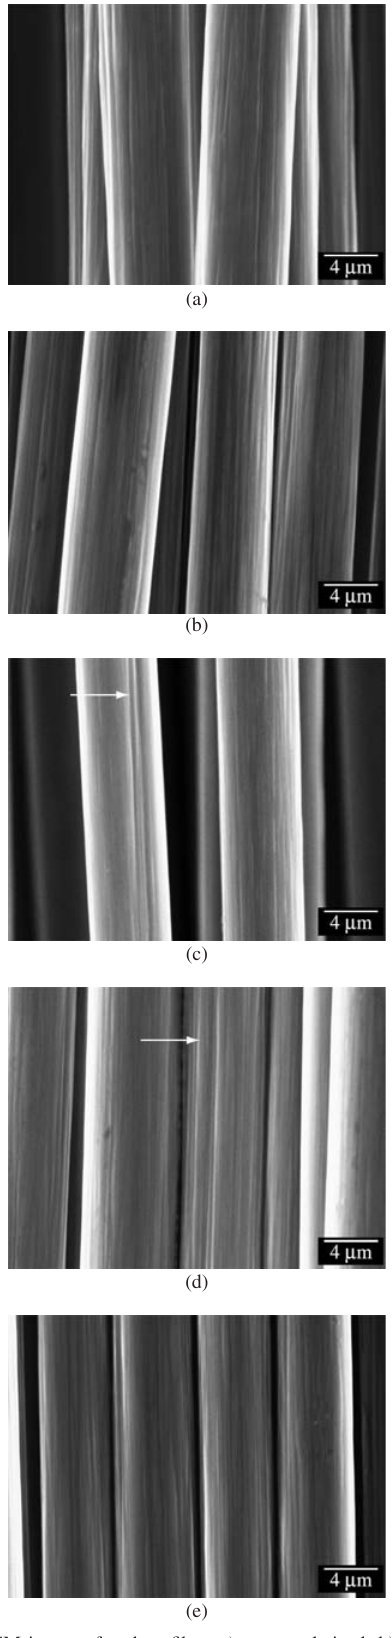
Figure 2. SEM image of carbon fiber: a) untreated sized; b) treated with hydrochloric acid (10 minutes); c) nitric acid (10 minutes); d) argon plasma for 10 minutes; and e) oxygen plasma for